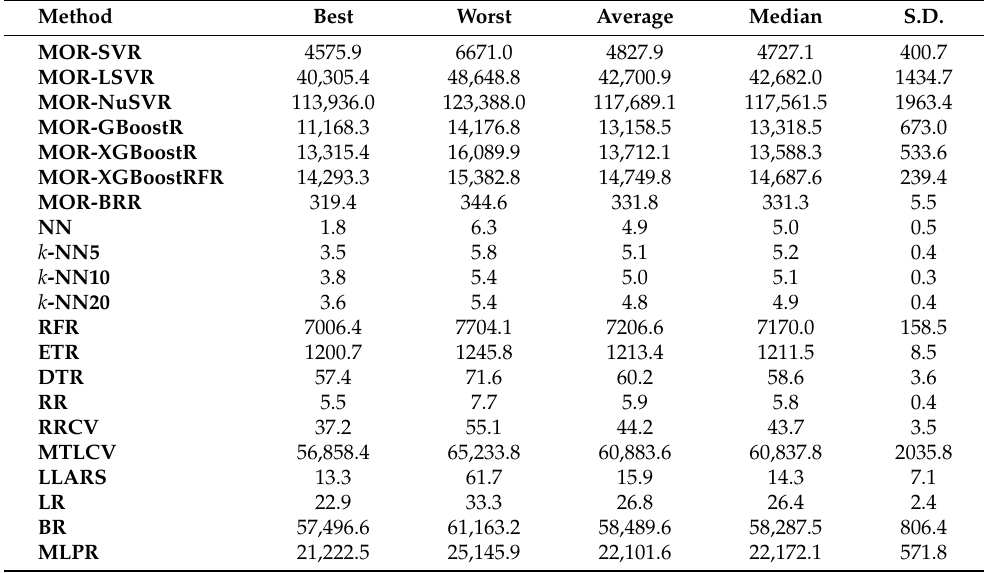
Table 4. Training time (in milliseconds (ms)) for all methods over 50 statistical runs (the first stage).